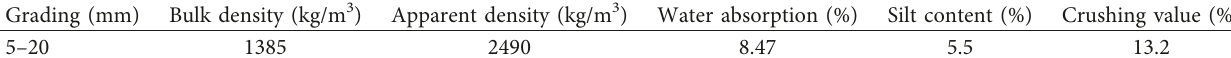
Table 3: Physical properties of RCA.